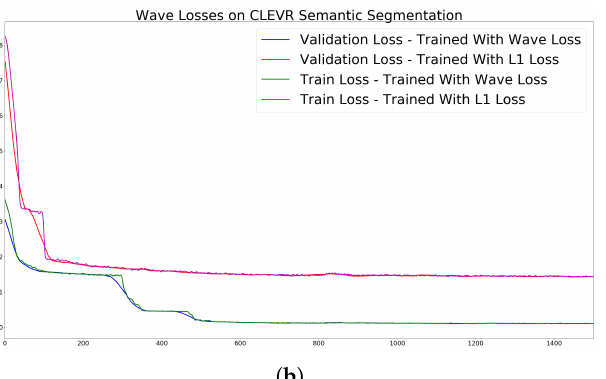
Figure 6. Losses on the CLEVR dataset averaged out on 20 independent runs; ( a ) L1 loss; ( b ) wave loss.